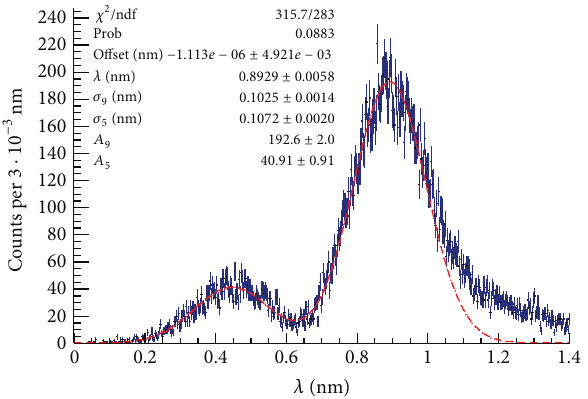
Figure 5: Short-distance (28cm) TOF spectrum. The analysis is similar to that for Figure 4. The dashed line is here to guide the eye, and the corresponding data points were not included in the